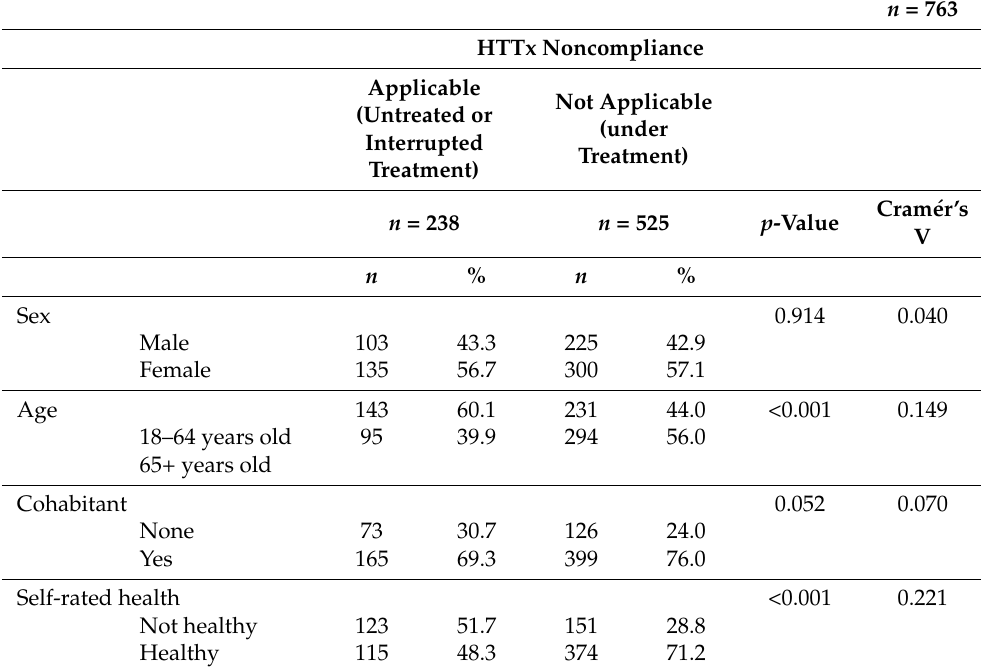
Table 2. Participant characteristics by hypertension treatment (HTTx) noncompliance.